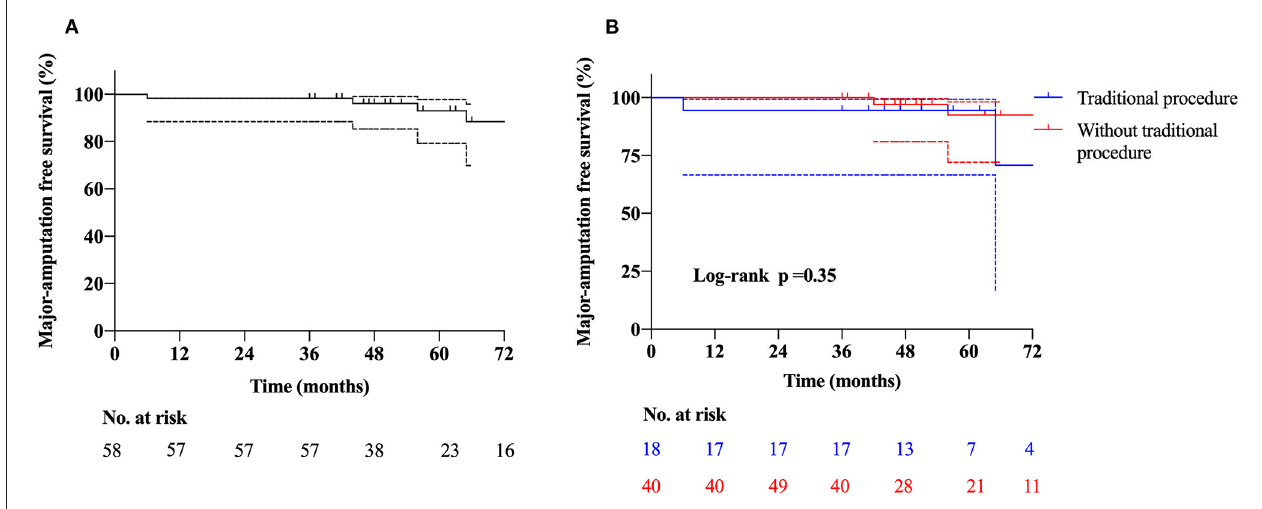
FIGURE 1 | Kaplan-Meier curves show the rates of (A) major amputation free survival, (B) major amputation free survival in patients with and without traditional procedures.